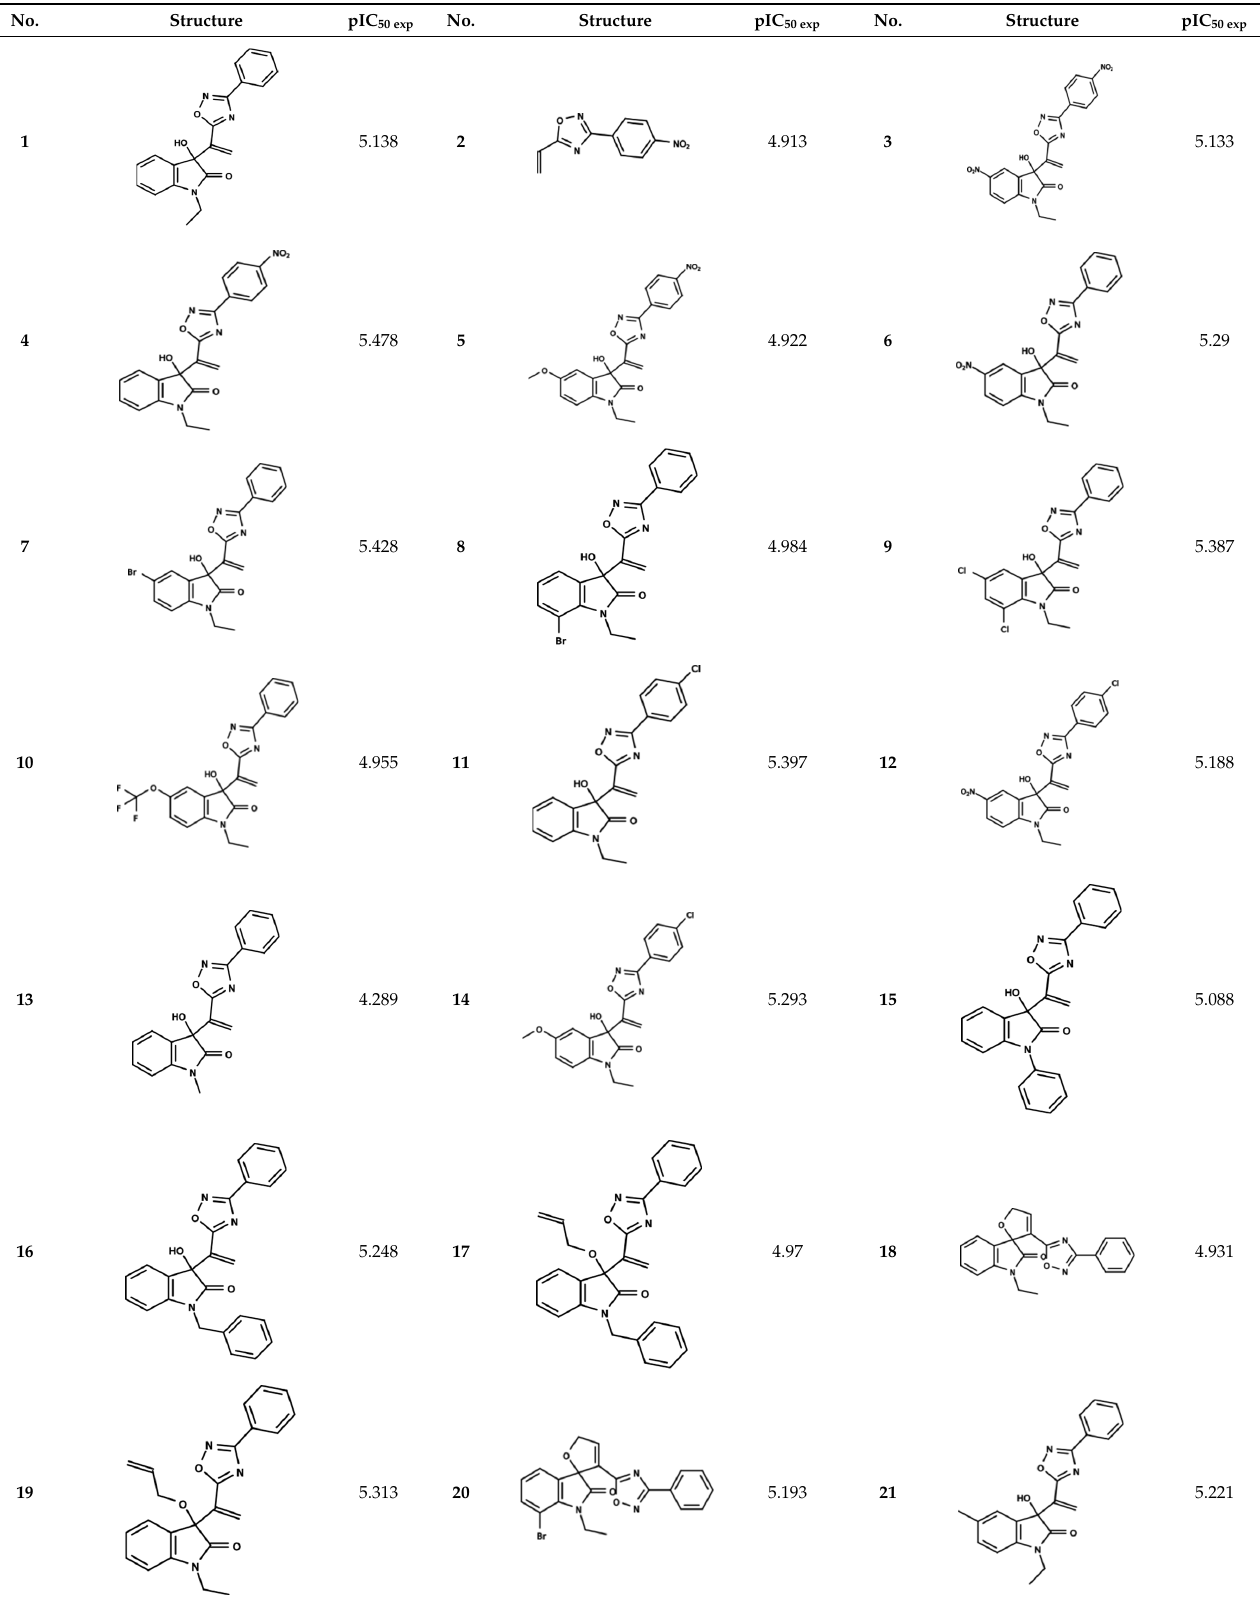
Table 6. Structures and pIC 50 values of the dataset compounds used in the QSAR studies.